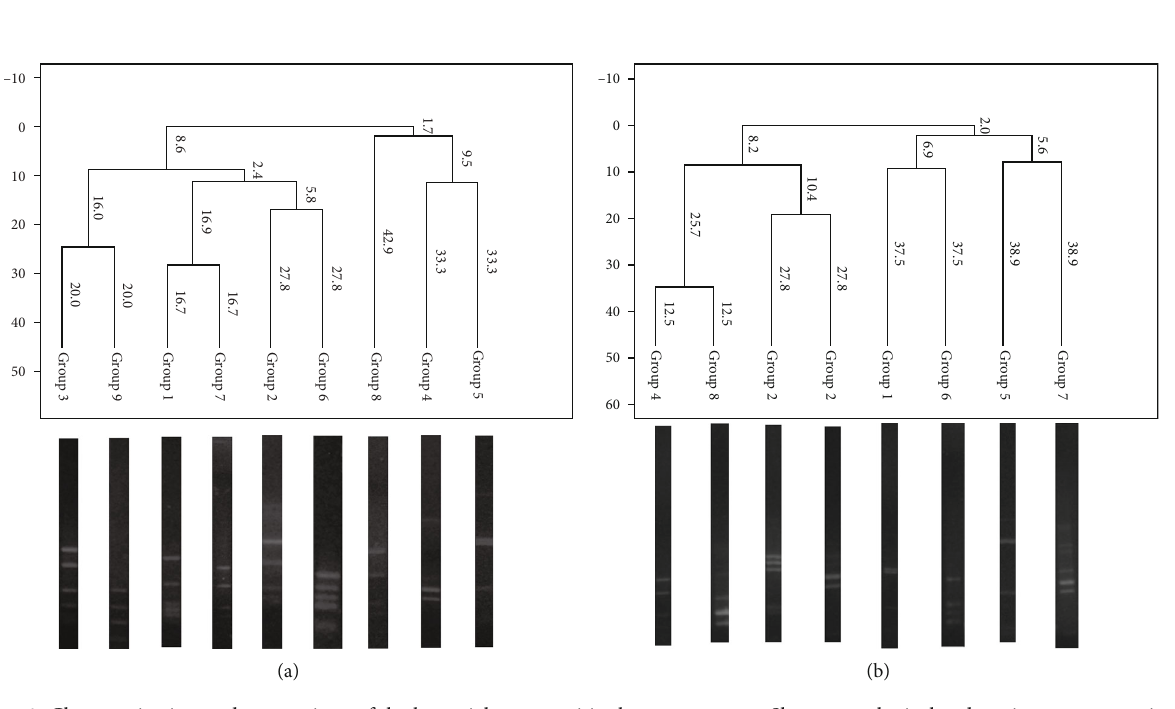
Figure 2: Characterization and comparison of the bacterial communities between groups. Shown are the isolated strains, representatives of each ribotype, like a graphical representation of the distance between the restriction enzyme patterns of the 16S rRNA sequences: (a) Msp-I enzyme (Moraxella sp.) and (b) Rsa-I enzyme (Rhodopseudomonas sphaeroides). Grouping by Sorensen-Dice coe ffi cient and UPGMA.